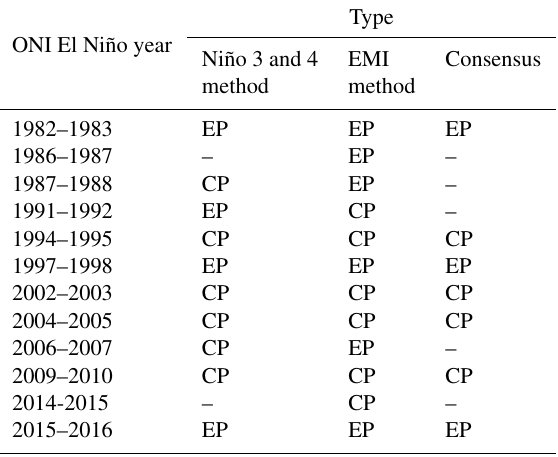
Table 1. The classification results of EP and CP El Niño of the total 12 El Niño events from 1980 to 2017 using the Niño 3 and 4 method and the EMI method. The en dash means that the method cannot distinguish the type of the El Niño